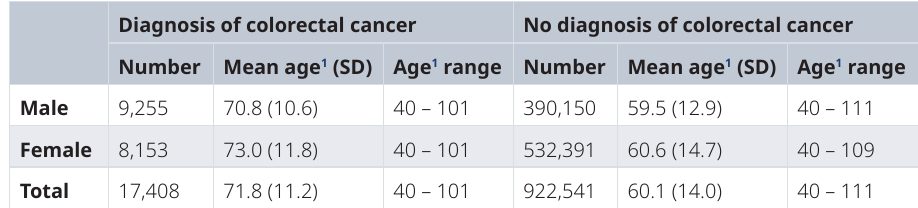
Table 5. Characteristics of the patient